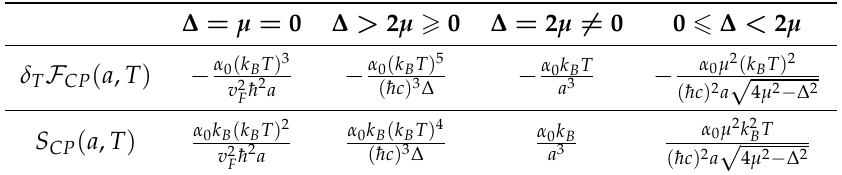
Table 1. Up to an order of magnitude asymptotic behaviors at arbitrarily low temperature of the thermal corrections to the Casimir-Polder energy (line 2) and of the Casimir-Polder entropy (line 3) under different relationships between the energy gap ∆ and chemical potential µ (line